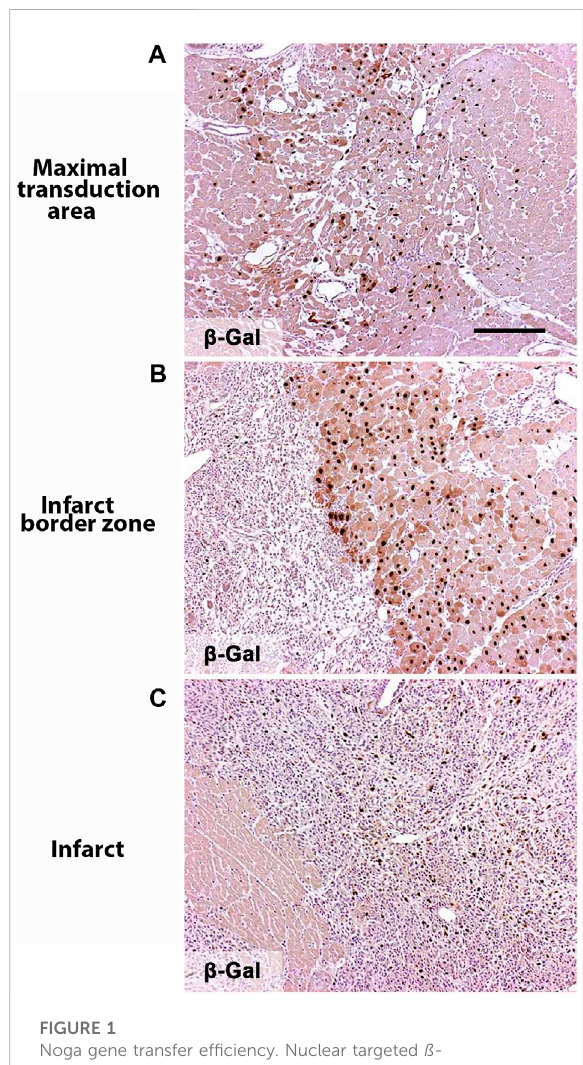
FIGURE 1 Noga gene transfer ef fi ciency. Nuclear targeted ß